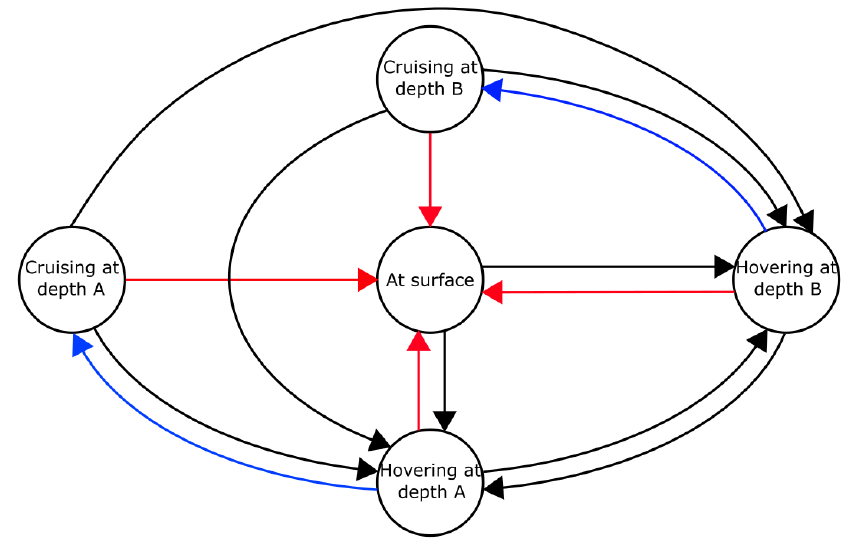
Figure 3. The states and transitions in the depth control process of an AUV.